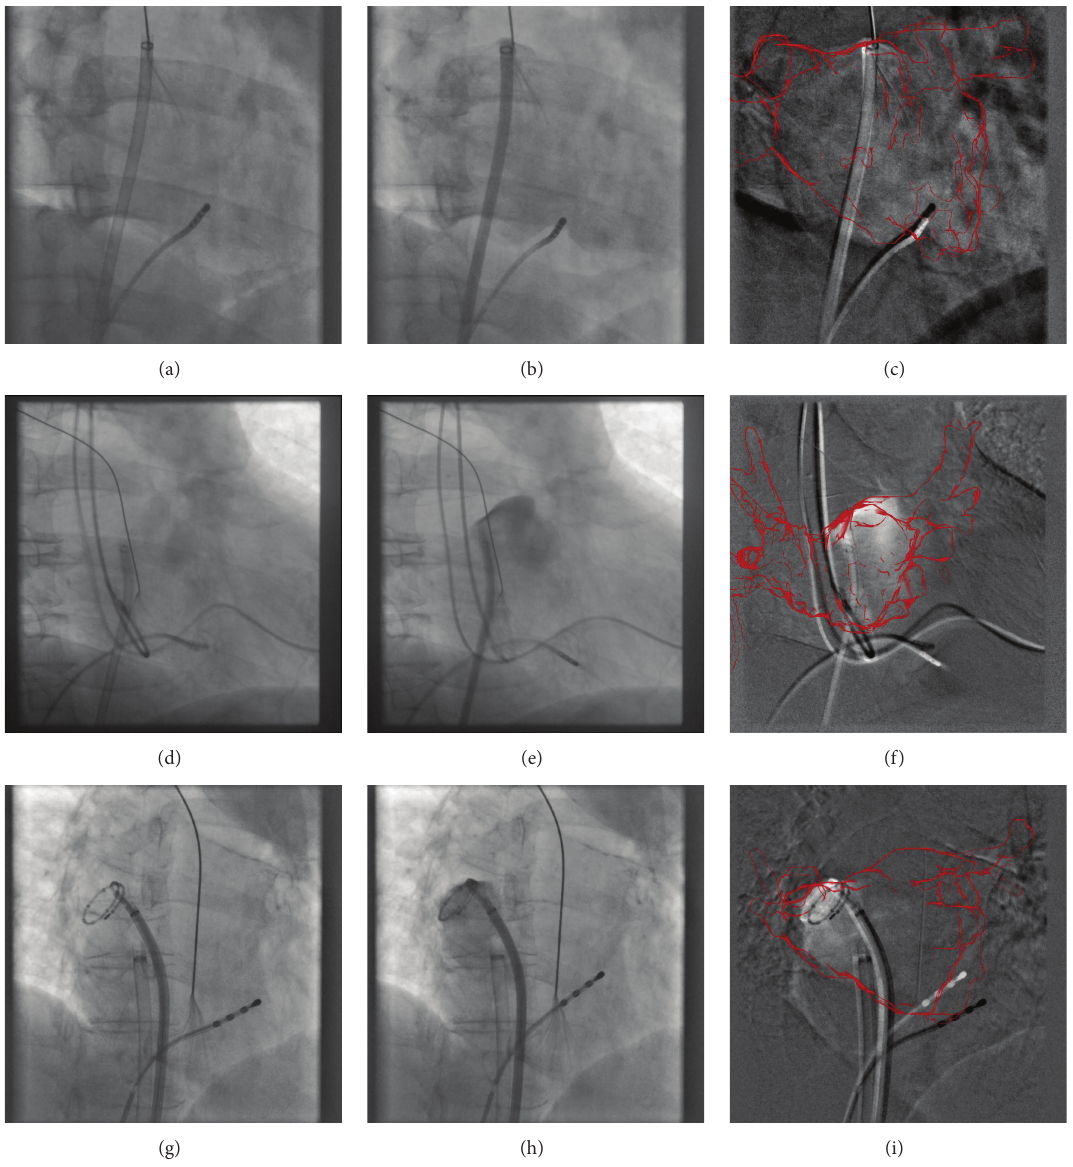
Figure 1: Three different contrast agent injections. The left column shows an uncontrasted frame, the middle column shows a contrasted frame of the sequence, and the rightmost column shows a subtraction of both images. The manually established ground-truth position of the left atrium is overlaid with red. The LA in image (c) appears only faintly contrasted and the CA just flows into the ventricle. On the other hand, image (f) shows disturbing motion artifacts caused by leads and wires associated with an implanted device. In image (i), the contrast agent is injected into a pulmonary vein and catheter motion artifacts are visible. While the spine in the center of this image vanishes, soft-tissue motion artifacts related to the lungs are visible at the left and right border,